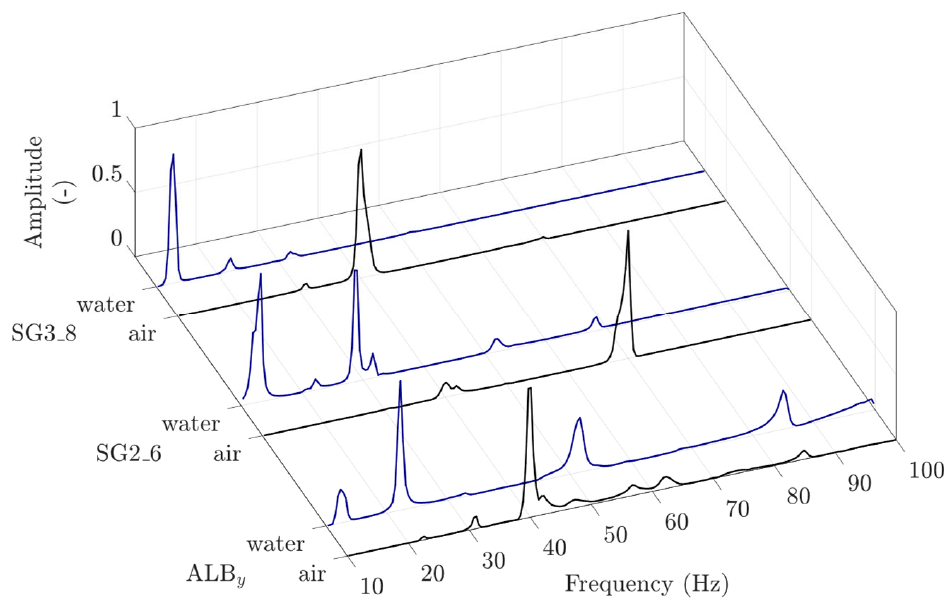
Figure 17. Maximum normalized spectra of the STFT measured from several sensors when the disk was excited with a chirp in the range of 0–100 Hz in air and water. Table 3. Frequency reduction ratios (FRRs) obtained from numerical and experimental modal analyses of the non-rotating disk in air and water. Mode Numerical